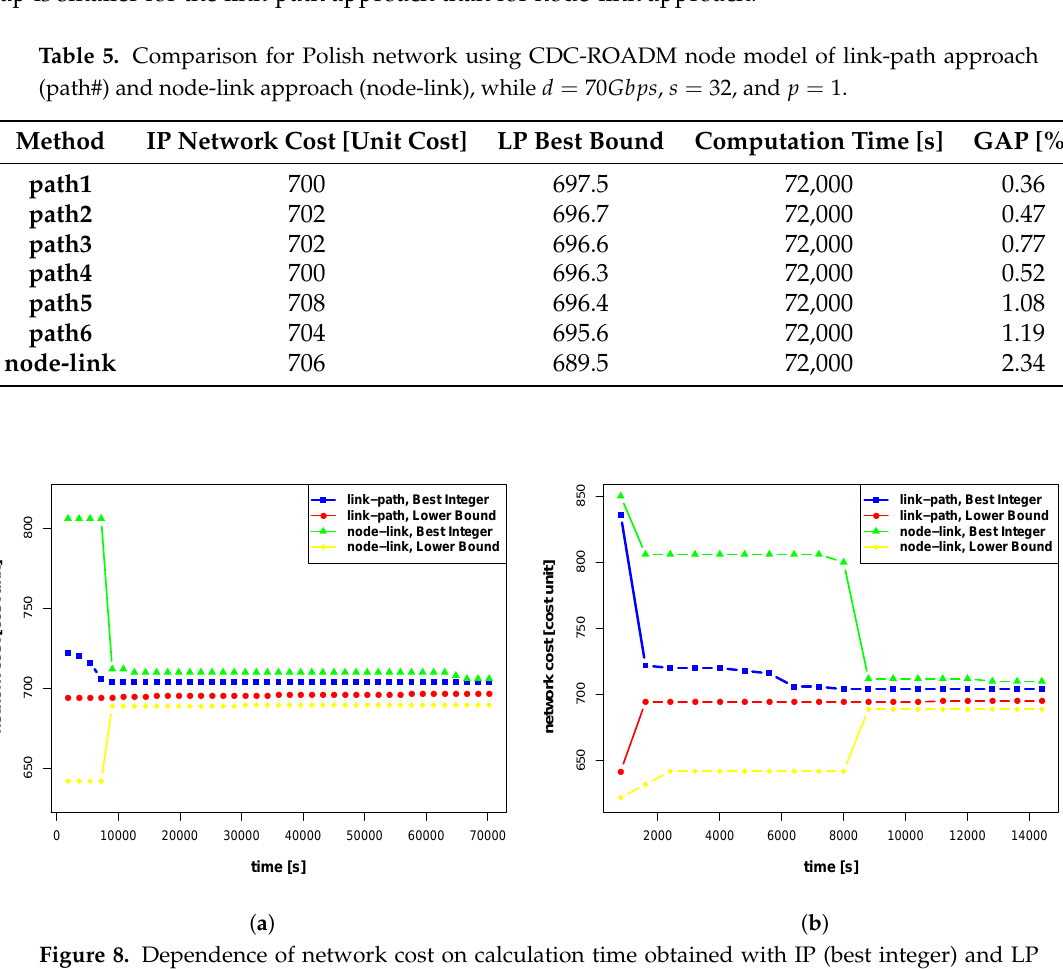
Figure 8. Dependence of network cost on calculation time obtained with IP (best integer) and LP (lower bounds) for: the entire computational time, 20 h ( a ) and for the initial 4 h ( b